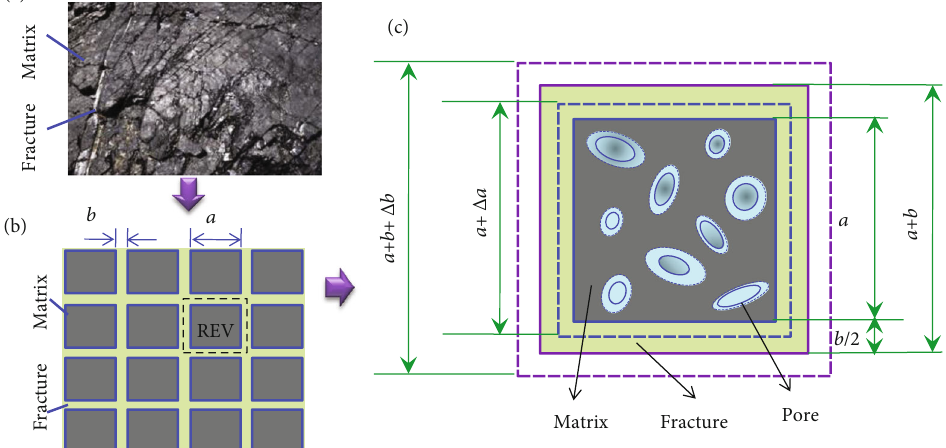
Figure 1: Mesostructure of coal mass: (a) actual coal surface; (b) conceptual model of coals; (c) size change in coal matrix and